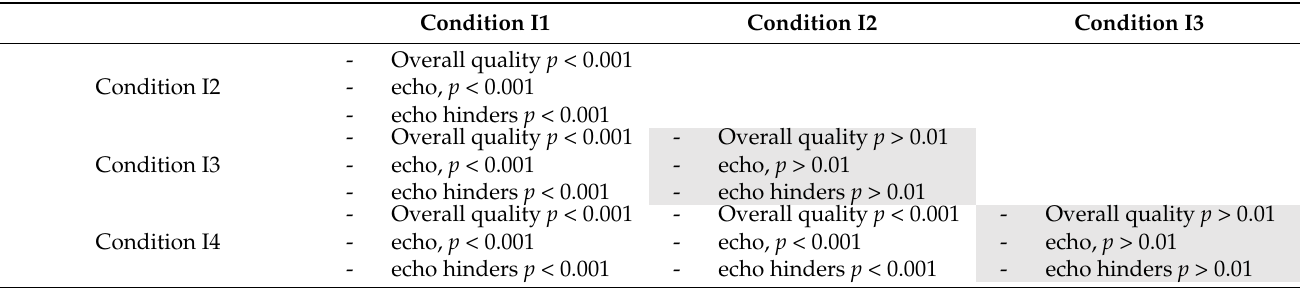
Table A2. Comparison Matrix between the Four Instruction Conditions Tested.